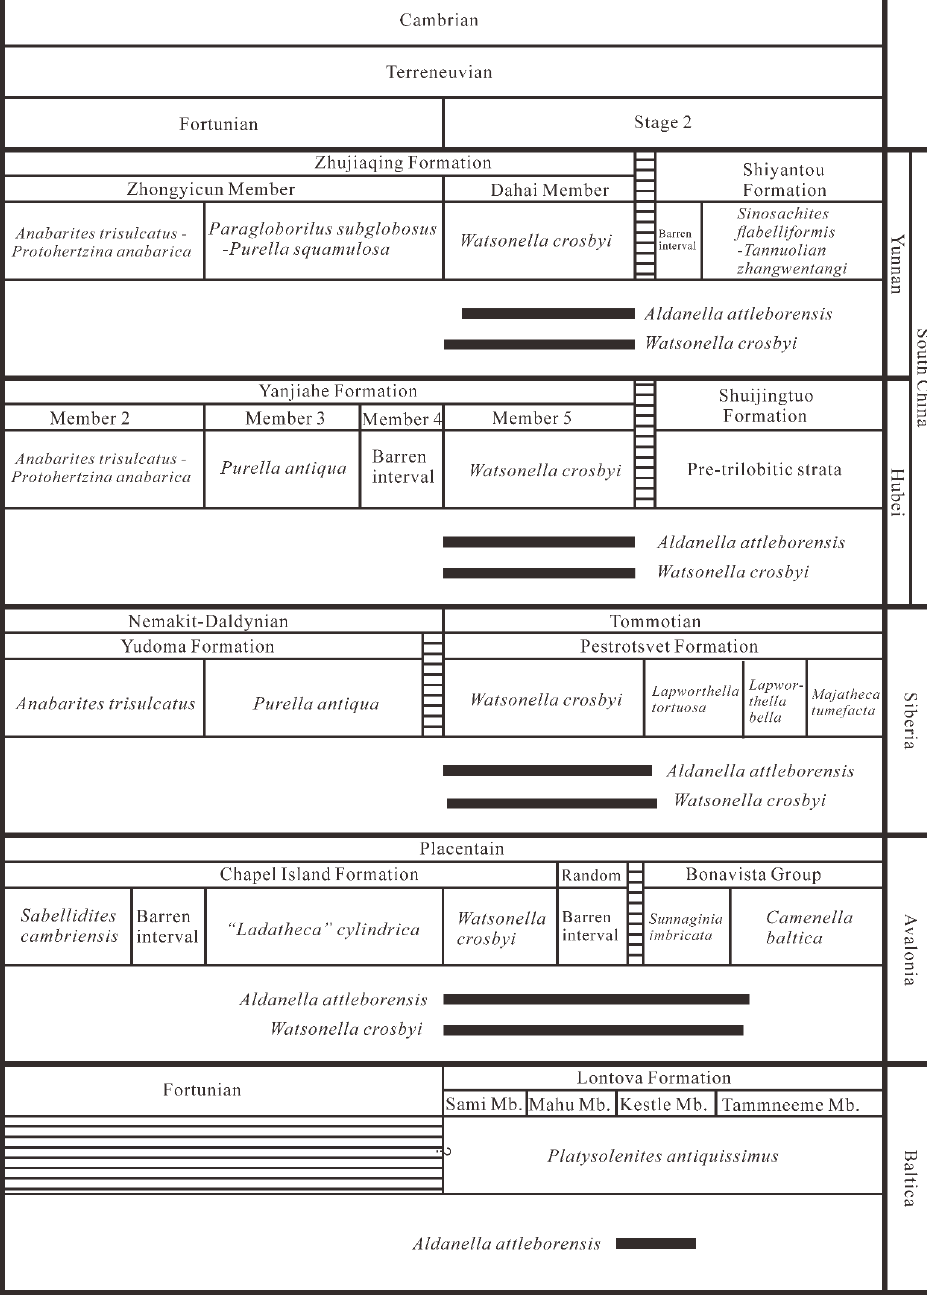
Figure 8. Global chronostratigraphic correlation chart of Fortunian and Stage 2, Terreneuvian. Biostratigraphic and biozone data from